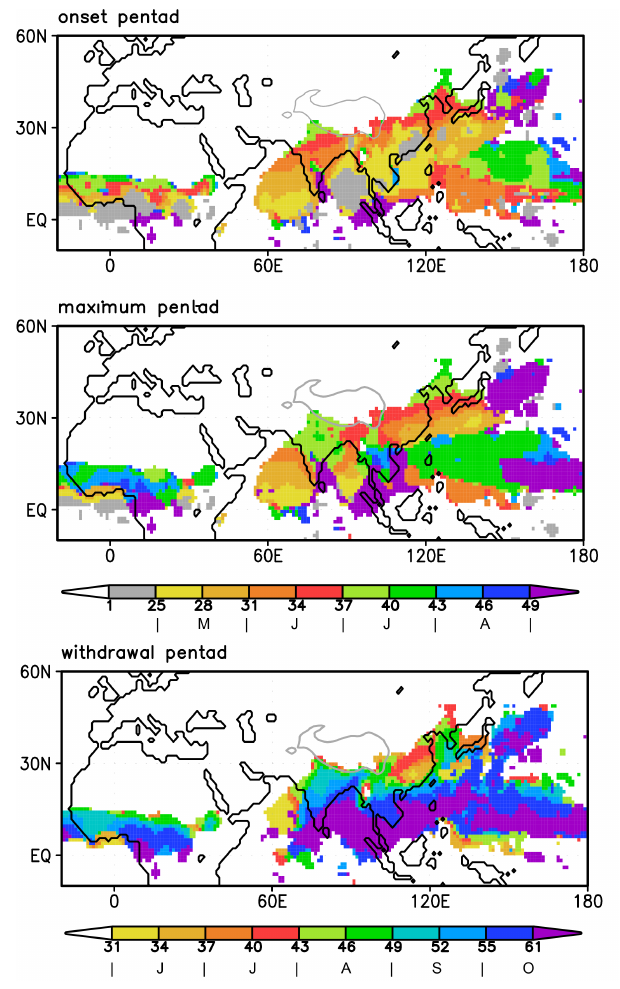
Figure 10. Pentad of monsoon onset, maximum monsoon rainfall, and withdrawal based on the observational data set of the Climate Prediction Centre (CMAP, 1979–2008, Xie and Arkin, 1997), cal- culated following the criteria of Wang and LinHo